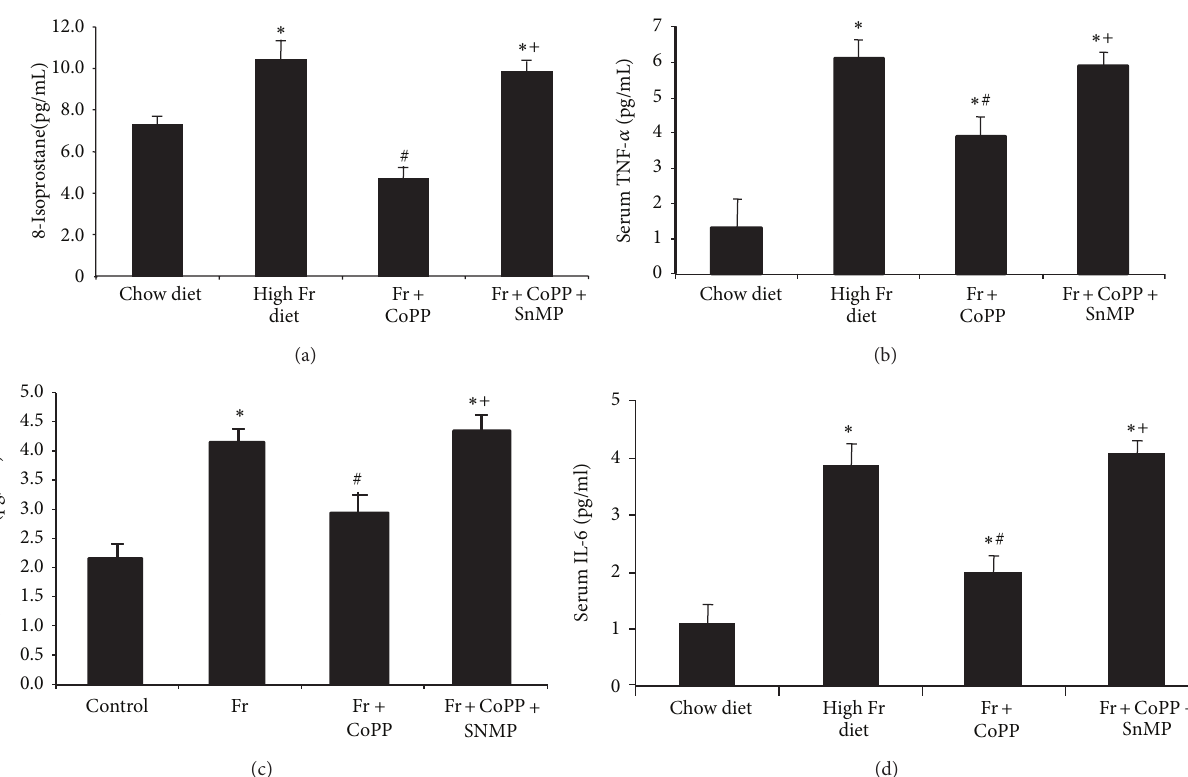
Figure 7: Assay of plasma concentrations of (a) isoprostane, (b) TNF 𝛼 , (c) IL-1, and (d) IL-6 in mice fed chow diet or high fructose diet and high fructose diet treated with CoPP, in the presence or absence of SnMP. Values represent means ± SEM of four independent mice per group. ∗ 𝑃 < 0.05 versus chow diet or # 𝑃 < 0.05 versus high fructose diet or + 𝑃 < 0.05 versus high fructose with